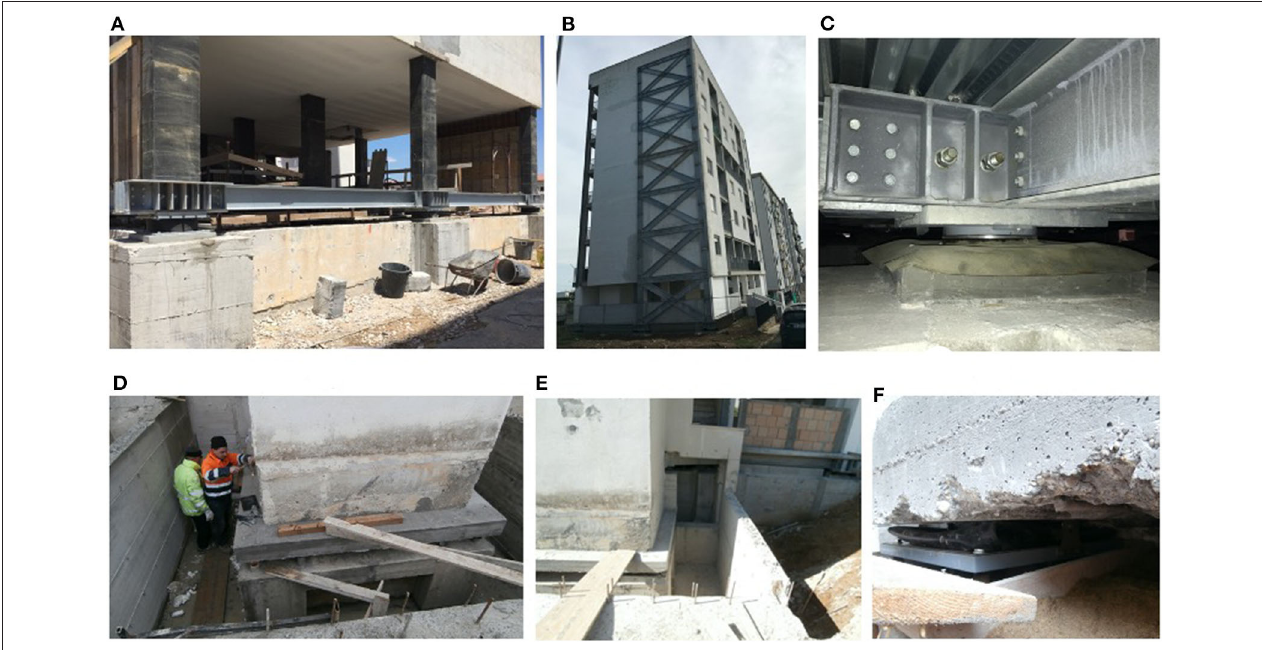
FIGURE 7 | Base-Isolated building. (A) Steel frames grid and seismic device mounted during a construction phase. (B) Lateral view showing the bracing system applied. (C) View a friction slider mounted (view from below the corrugated steel panels). (D,E) Installation of seismic devices under concrete core hosting the elevator. (F) View of the friction slider mounted under a vertical wall.